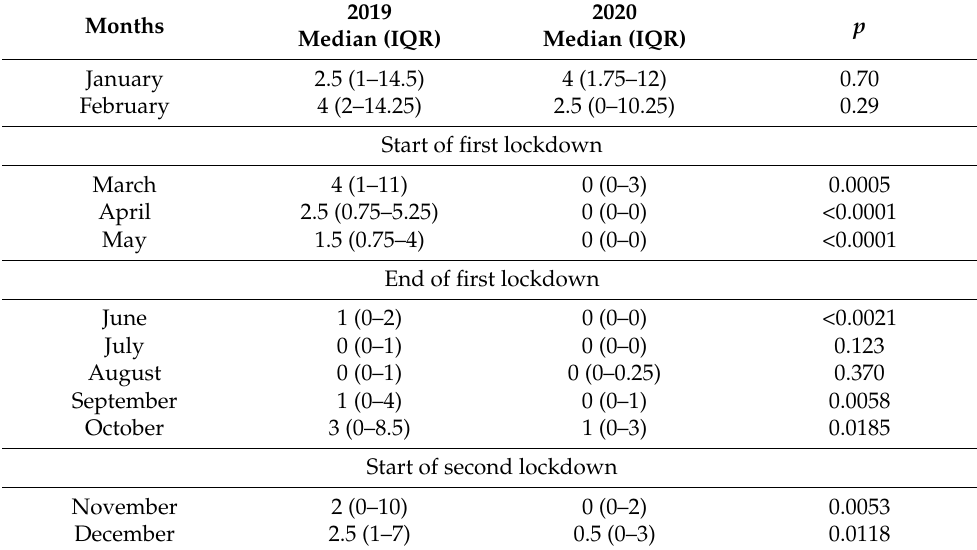
Table 4. Number of patients with laryngitis recorded monthly in 2019 compared to 2020, in the study population of 35,787 children aged 0–14 years.